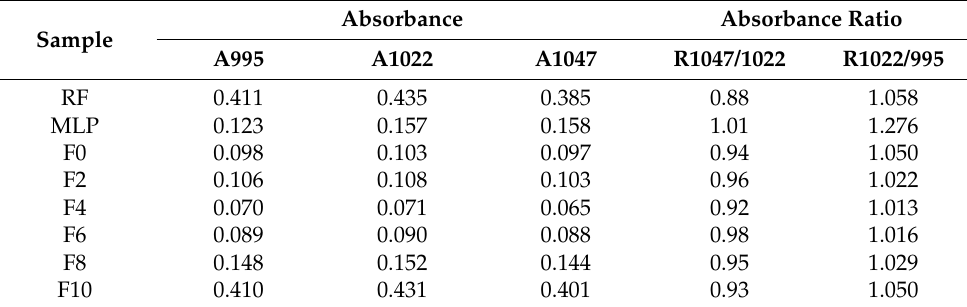
Figure 7. FTIR spectra of F0 and FRN samples. F0 represents 0% MLP, F2 represents 2% MLP, F4 represents 4% MLP, F6 represents 6% MLP, F8 represents 8% MLP, and F10 represents 10% MLP. Table 7. Absorbance ratio of RF, MLP, F0, and FRNs .